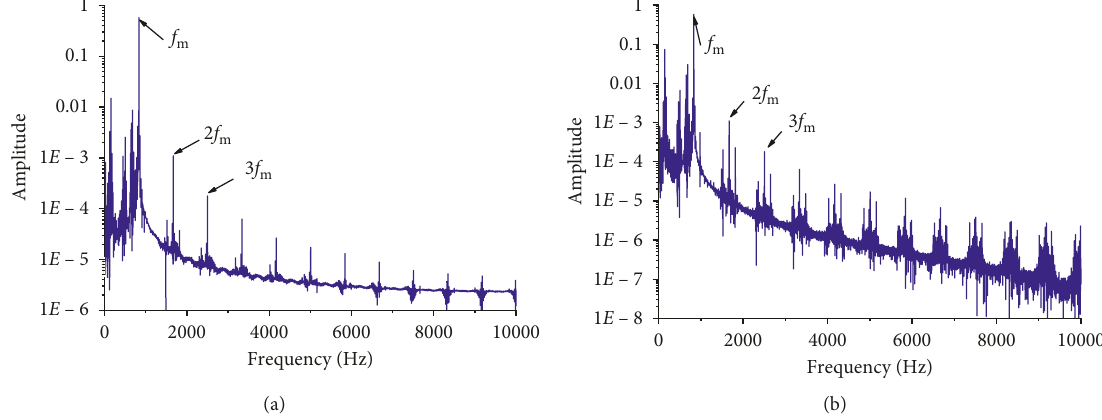
Figure 10: Frequency spectrum diagram of vertical vibration acceleration of bogie (frequency range: 0–10000): (a) health gear (b) the crack length of the pinion is 4mm.